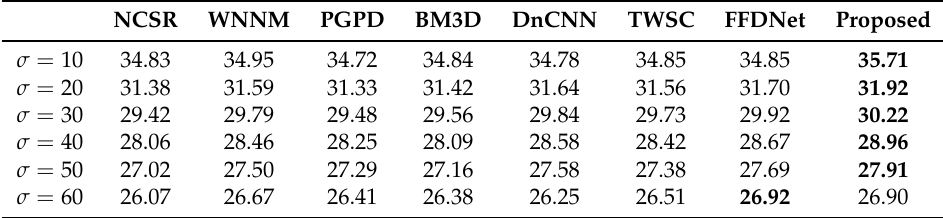
Table 2. Average PSNRs (dB) of the competing methods evaluated on commonly used test images with noise level σ = 10, 20, 30, 40, 50 and 60.